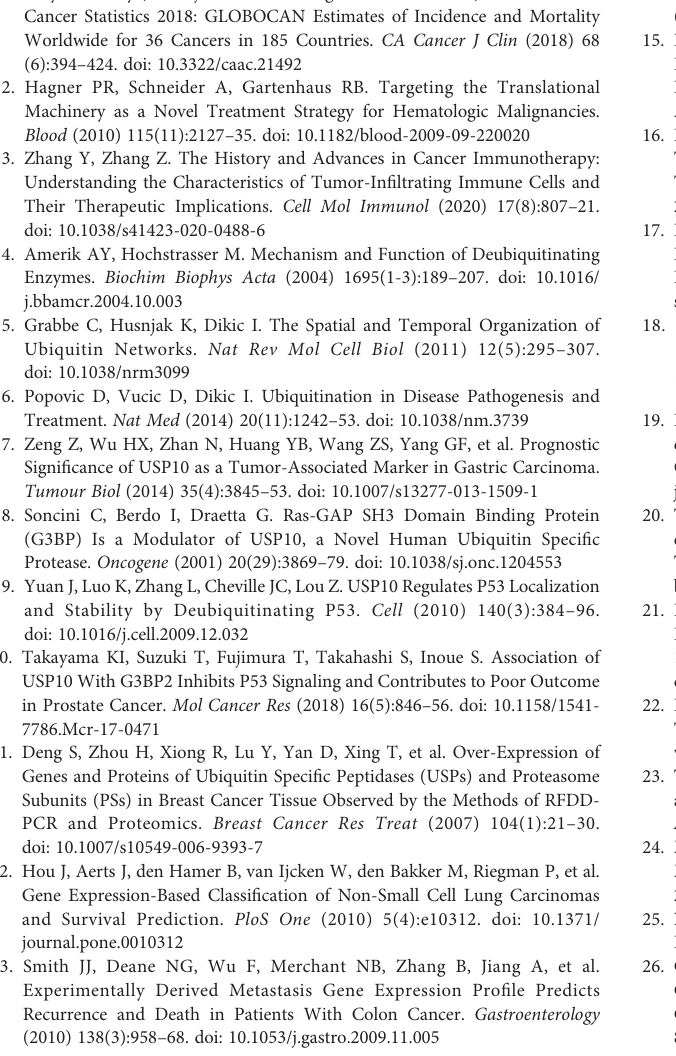
negative Spearman ’ s correlation; gray box, no signi fi cant correlation. Signi fi cance is indicated by a P -value < 0.05. Supplementary Figure 4 | Analysisoftheprognosticvalueof USP10 expressionin immune cell subsets in patients with PAAD and LIHC using Kaplan – Meier Plotter. (A) In PAAD, high USP10 expression was linked to increased in fi ltration of B cells, NK cells,Tregs,andTh2cells(all P <0.05);andwithdecreasedin fi ltrationofCD4+Tcells, macrophages,and Th1cells (all P < 0.05),andpredicted inferior prognosticsurvival in patients with PAAD. However, USP10 expressionwith increased (OS,HR= 2.41, P = 0.027) or decreased (OS, HR = 2, P = 0.012) CD8+ T cell in fi ltration had a marked impact on the survivalof patients with PAAD andpredicted a worse survival outcome. (B) In LIHC, overexpression of USP10 and abundant in fi ltration of B cells and Treg cells (all P < 0.05) or reduced in fi ltration of Th1 cells ( P < 0.05) predicted a worse prognosis. Interestingly, USP10 expression in LIHC correlated statistically with enriched in fi ltration of macrophages (OS, HR = 1.76, P = 0.021), indicating a worse prognosis. In contrast, USP10 expression was associated with reduced in fi ltration of macrophages (OS, HR = 0.54, P = 0.021), predicting a better survival